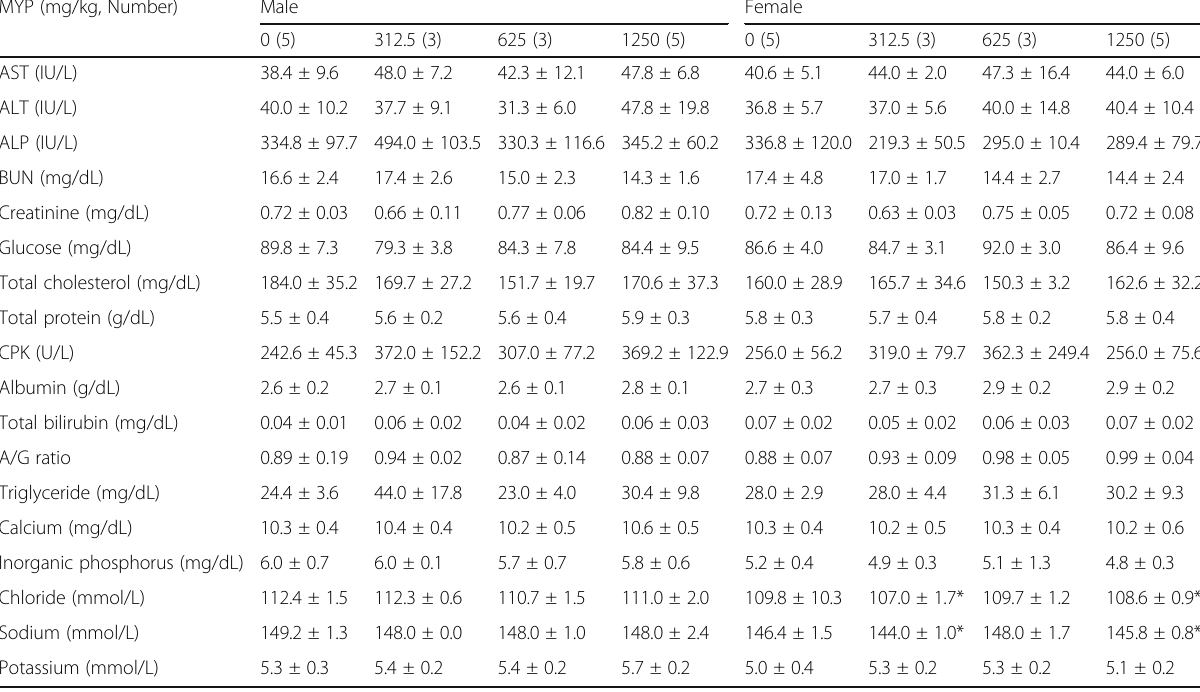
Table 4 Serum chemistry analysis after administration of Myelophil for 13 weeks